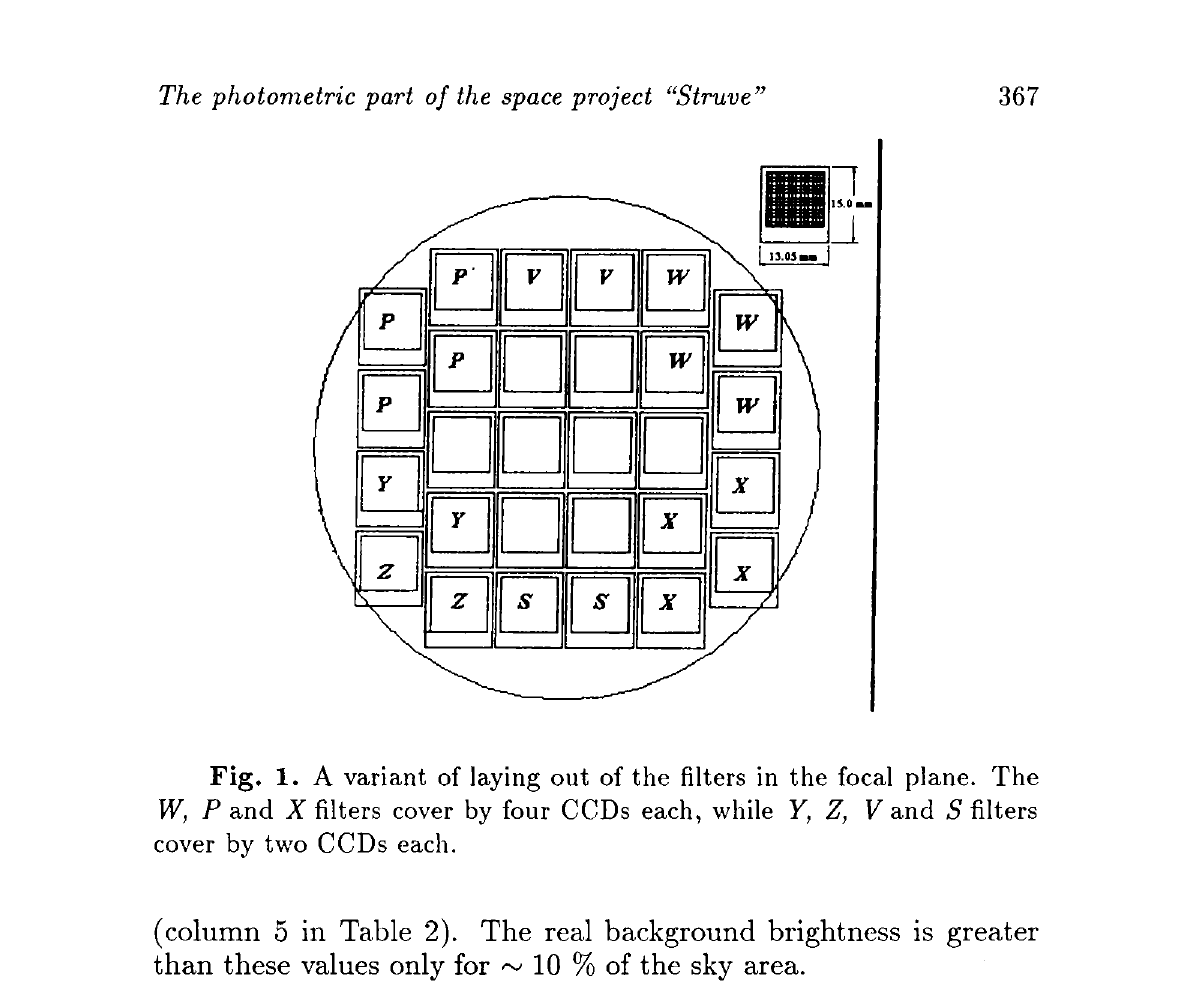
Fig. 1. A variant of laying out of the filters in the focal plane. The W, P and X filters cover by four CCDs each, while Y, Z, V and S filters cover by two CCDs